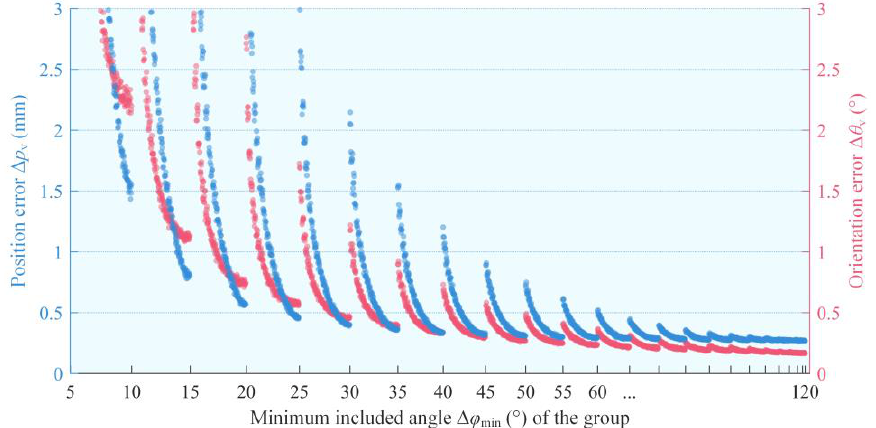
Figure 7. Recognitions errors of sorted marker groups, with position error in blue color and orientation error in pink color.